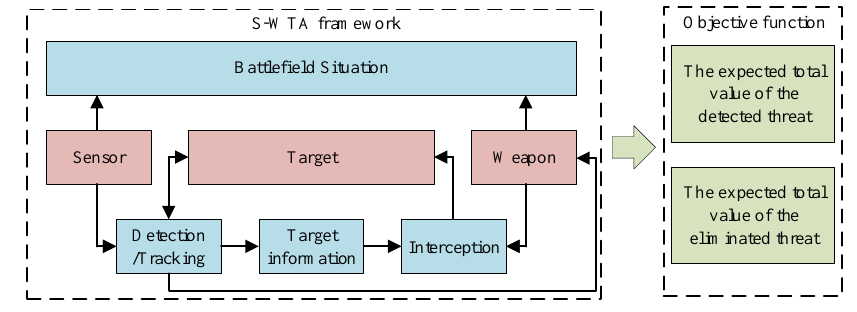
Figure 4. The synthetical S-WTA